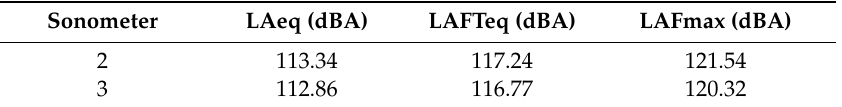
Table 2. Measures from inside sonometers.